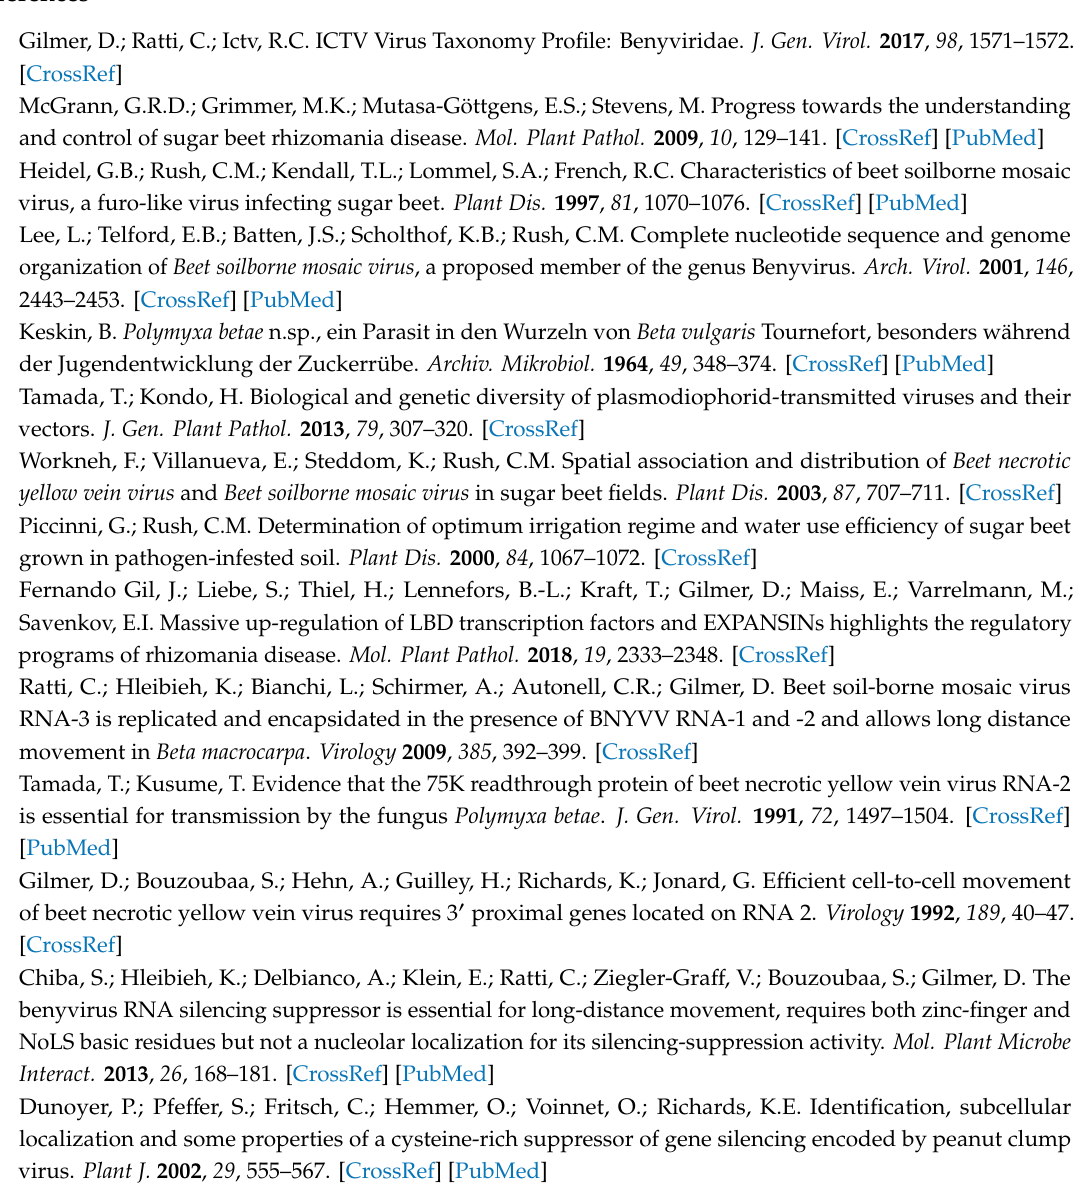
Table S8: Transcription factor (TF) enrichment analysis using di ff erentially expressed TF (log2 fold change > 2 or < − 2) identified in BNYVV and BSBMV infected plants. Table S9: Log2 fold change of plant defence-related transcription factors (TFs) di ff erentially expressed in BNYVV and BSBMV infected